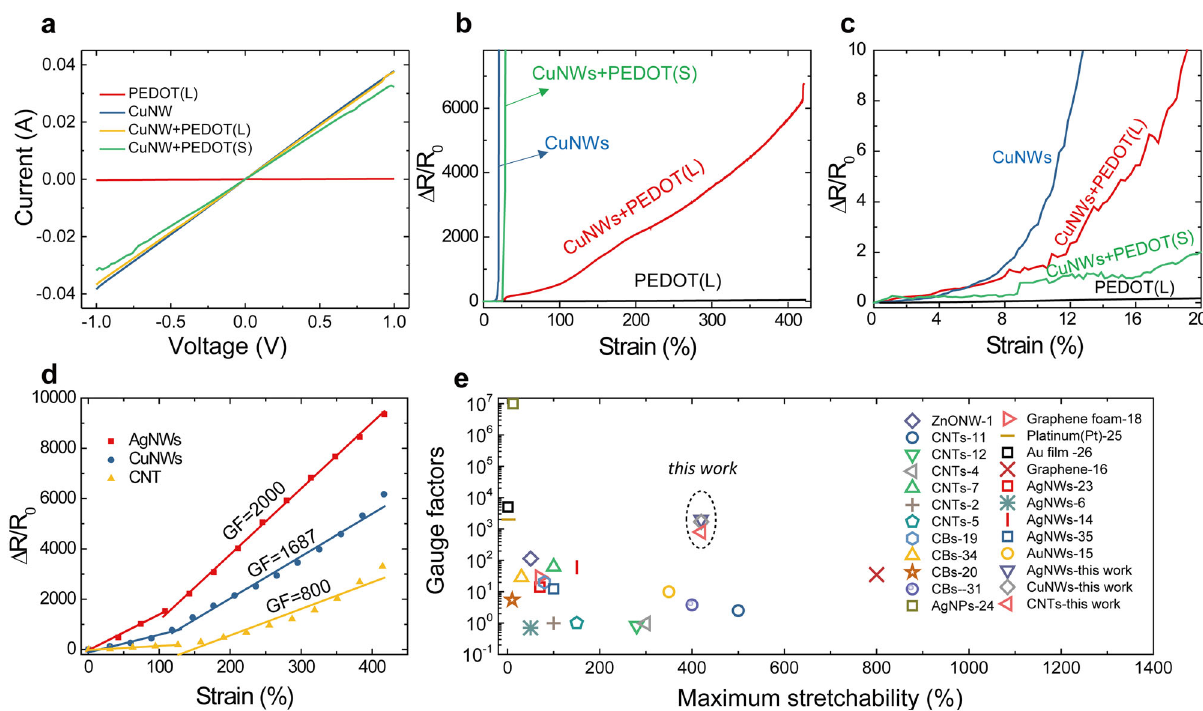
Fig. 2 Electromechanical properties of the strain sensors. a I – V curves of the strain sensors with different structures; PEDOT denotes PEDOT: PSS. b Relative resistance variations of the sensors during stretching. c Relative resistance variations of the sensors under a small strain. d Relative changes in the resistances of the sensors based on AgNWs, CuNWs, or carbon nanotubes (CNTs) from 0 to 420% strain. Extraction of the GFs by linearly fi tting the plot of the electrical resistance variation as a function of the applied strain. e Comparisons of the average GFs against the maximum stretchability for previously reported strain